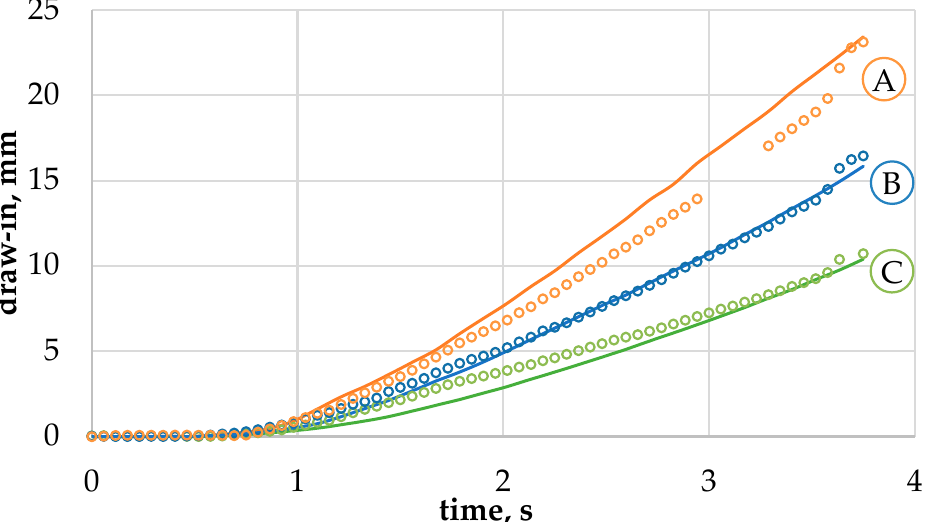
Figure 7. Comparison between experimental and numerical draw-in at points A, B, and C after calibration of FE model.